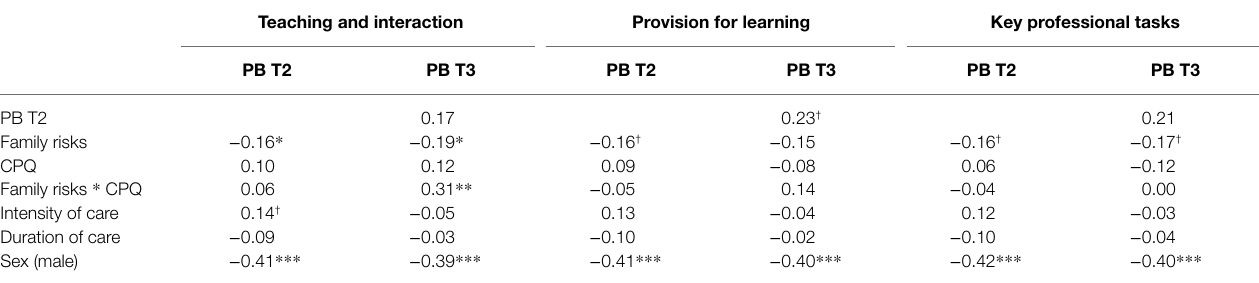
TABLE 6 | Standardized regression coefficients of the model for prosocial behavior ( N =